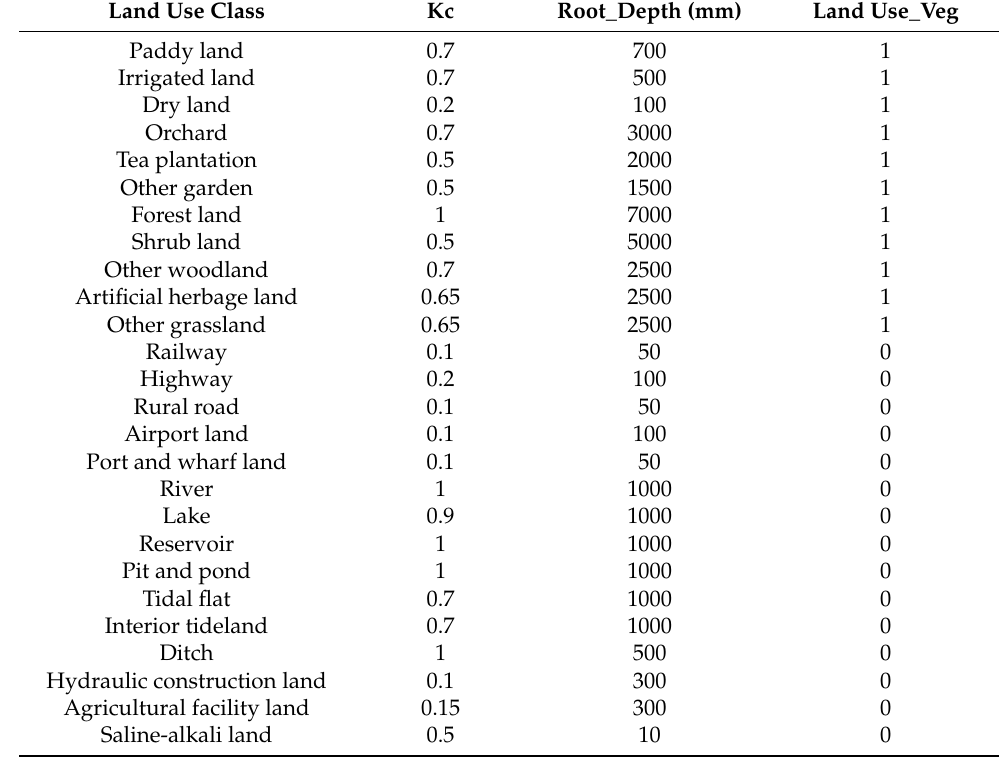
Table 1. Biophysical table used for the baseline InVEST water yield model